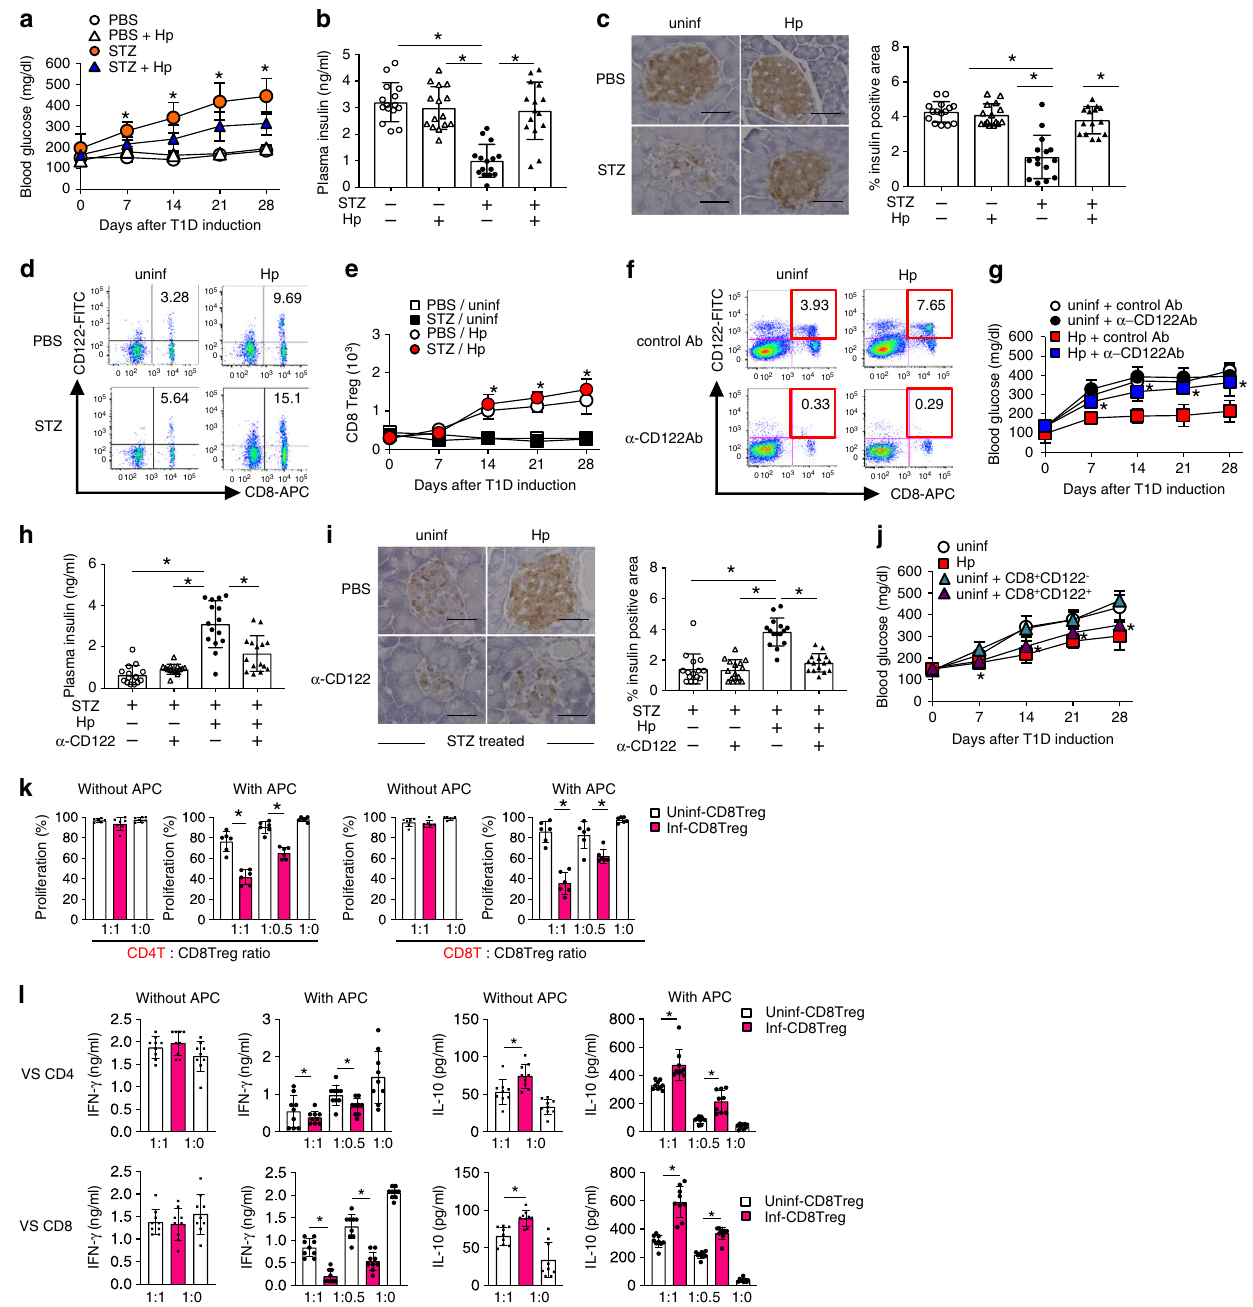
Fig. 1 CD8 + Treg cells mediate suppression of STZ-induced diabetes by H. polygyrus . a – c Mice were administered STZ at 14 days after infection with Hp. a Blood glucose concentrations were monitored, b plasma insulin was measured, and c pancreatic sections were stained with an anti-insulin antibody at 14 days after T1D induction. Representative histological images are shown ( left panels ), and a bar graph depicts the percentage of the stained area observed under a microscope ( right panel ). d CD8 + Treg cells de fi ned as CD8 + CD122 + cells in the pancreatic LN from mice before and at 14 days after infection with Hp were quanti fi ed by fl ow cytometry. The numbers indicate the percentages of CD8 + Treg cells in the FSC/SSC-gated lymphoid cells. e Kinetics of the absolute number of CD8 + Treg cells in the pancreatic LN. f – h Hp-infected mice were administered an anti-CD122 antibody immediately before and after T1D induction. f Spleen cells of these mice were assessed for the depletive effects of the antibody on CD122-expressing cells by fl ow cytometry. The effects of this manipulation on blood glucose ( g ), plasma insulin levels ( h ), and pancreatic β -cells ( i ) were evaluated as described in a – c . j Blood glucose of mice that received CD8 + Tregs or non-Treg CD8 + CD122 - cells was monitored after injection of STZ. k TCR-driven proliferation of CD4 + ( left panels ) and CD8 + T ( right panels ) cells in the presence or absence of antigen-presenting cells cultured with CD8 + CD122 + cells from the indicated mice at the indicated ratio was evaluated by fl ow cytometry. l Cytokine concentrations were quanti fi ed in supernatants of the cultured cells in k . Values represent the mean ± SD of 15 mice (sum of three repeated experiments, fi ve mice each). Experiments in l and k were repeated three times, and values represent the mean ± SD of 10 mice (sum of three repeated experiments, three or four mice each). Asterisks denote statistical signi fi cance at p < 0.05 calculated by the two-way ANOVA ( a , e , g , j ) and Tukey post-hoc analysis ( b , c , h , i , k , l ). Scale bars indicate 40 μ m ( c , i ). All experiments were repeated at least three times with similar